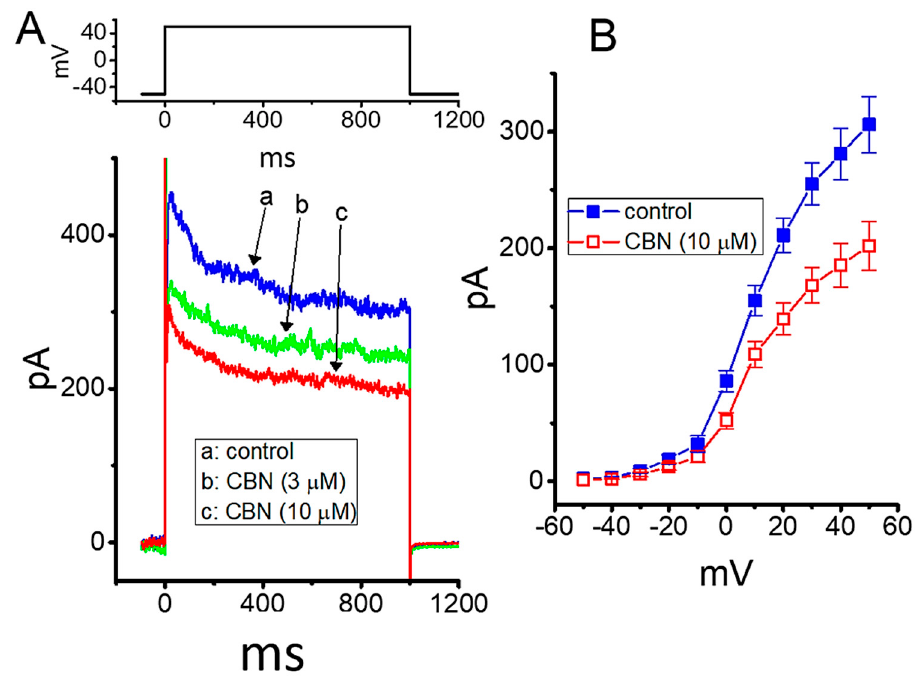
Figure 7. Effect of CBN on delayed-rectifier K + current ( I K(DR) ) in GH 3 cells. In this set of experiments, cells were bathed in Ca 2+ -free, Tyrode’s solution containing 1 µM TTX, and we filled the electrode with K + -containing solution. ( A ) Representative current traces obtained in the absence (a) and presence of 3 µM CBN (b) or 10 µM CBN (c). ( B ) Mean I-V relationship of I K(DR) without ( ■ ) or with ( ○ ) the addition of 10 µM CBN (mean ± SEM; n = 7 for each point). Current amplitude was taken at the end of each depolarizing voltage command from a holding potential of − 50 mV with a duration of 1 s.